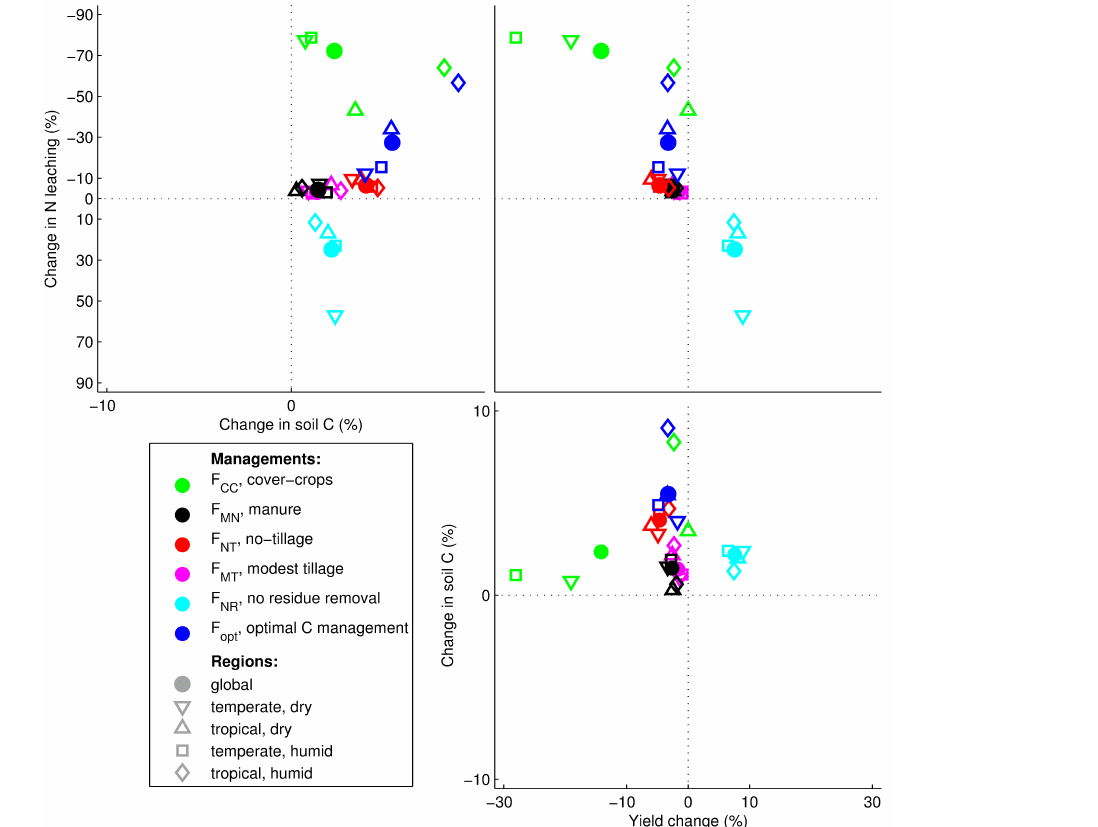
Figure 3. The simulated relative response (%) of soil carbon to management options (Table 2) compared to the standard set-up, averaged for 1996–2005 and displayed as the global response (filled symbol) and per climatic region. Note the reversed axes for N leaching (all axes display scales from reduced to enhanced ecosystem services with the upper right corner representing a win-win